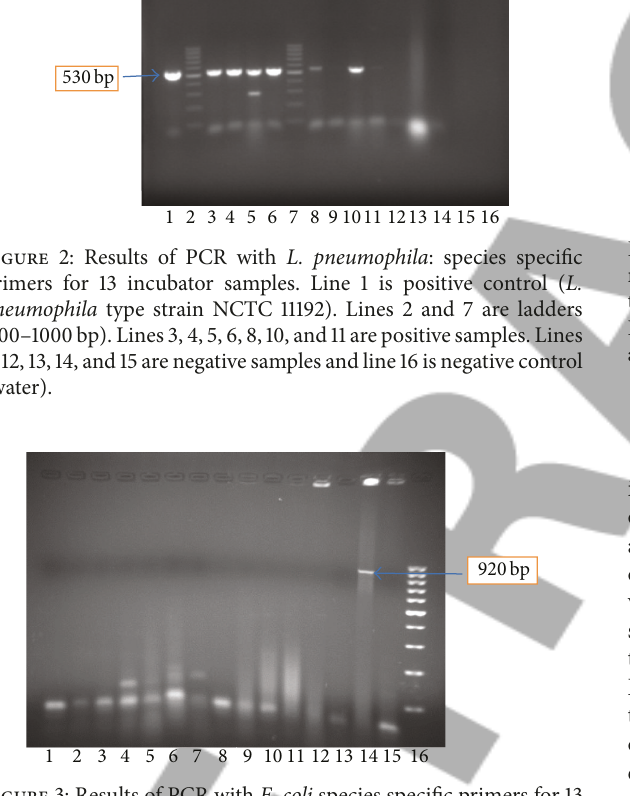
Figure 3: Results of PCR with E. coli species specific primers for 13 incubator samples. Line 16 is 100–1000 bp ladder. Line 15 is negative control (water). Line 14 is positive control ( E. coli type strain ATCC 44338). All samples (lines 1–13) are negative.